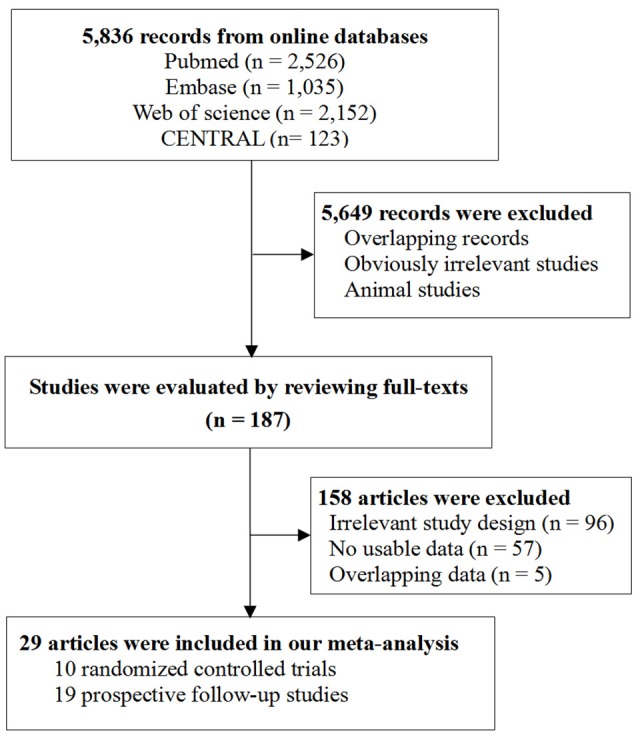
Flowchart of study selection in the meta-analysis.